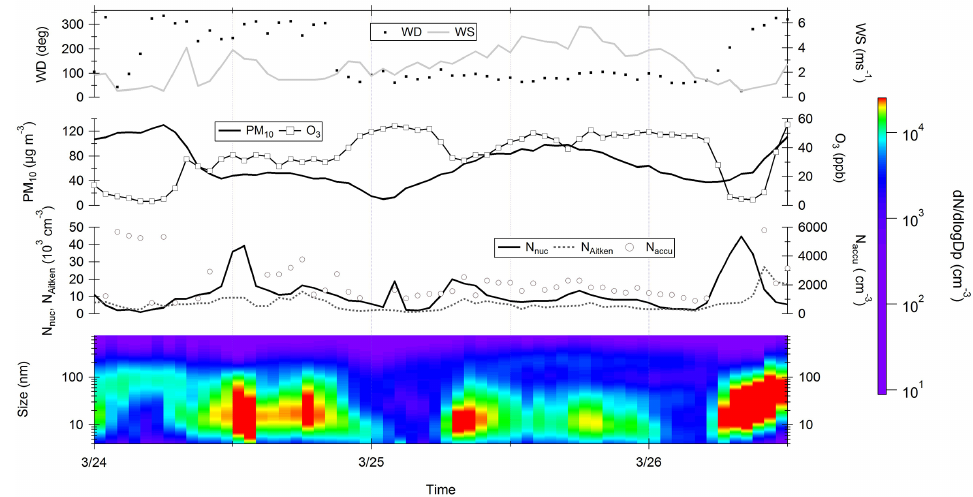
Figure 9. Time series of PSD, the N 4 − 25 , N 25 − 100 , N 100 − 736 , PM 10 , ozone (O 3 ) and wind direction/speed measured from 24 to 26 March 2013 (from bottom to top).